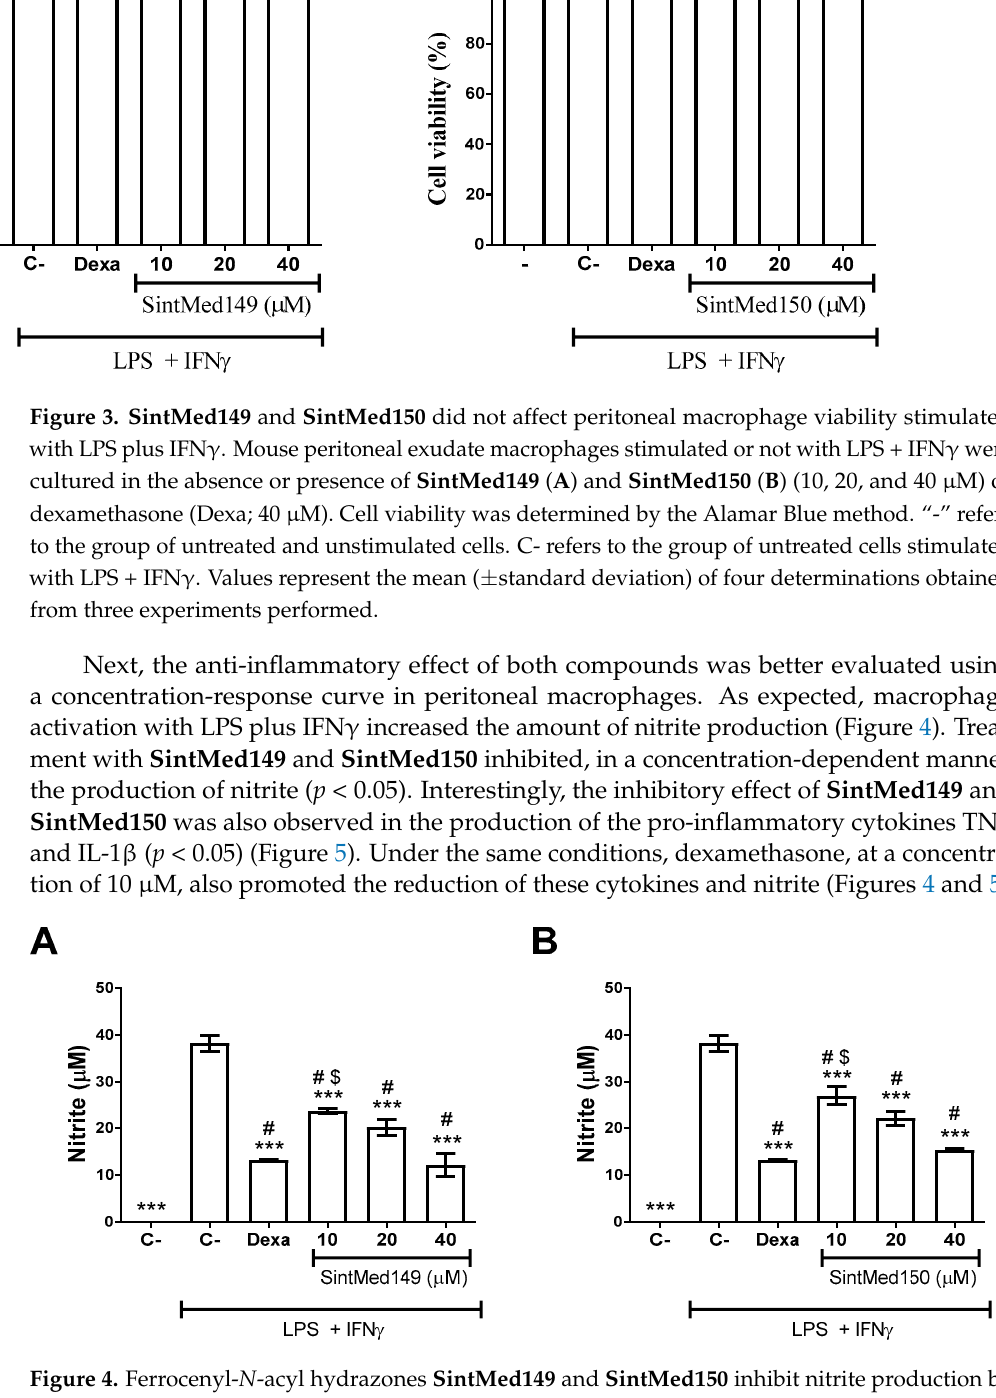
Figure 5. Assessment of cytokine production by peritoneal macrophages treated with SintMed149 or SintMed150 . Mouse peritoneal exudate macrophages stimulated or not with LPS + IFN- γ were cultured in the absence or presence of SintMed149 ( A , C ) or SintMed150 ( B , D ) (10, 20, and 40 µM)